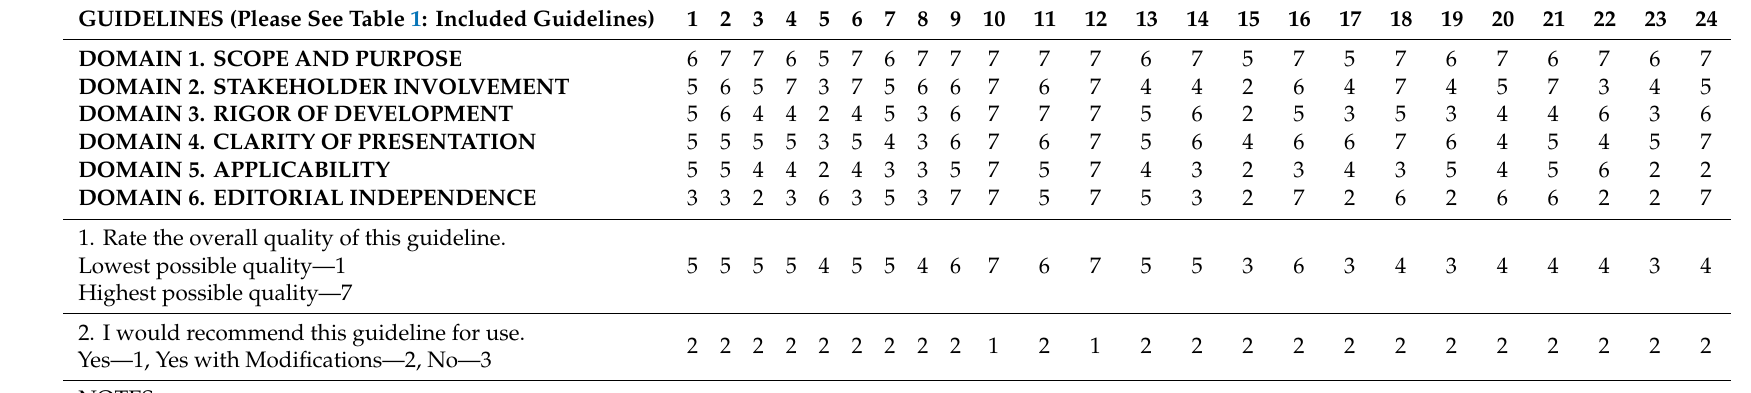
Table 3. Short version of the Agree II instrument (Strongly Disagree—1, Strongly Agree—7). GUIDELINES (Please See Table 1: Included Guidelines) DOMAIN 2. STAKEHOLDER INVOLVEMENT DOMAIN 4. CLARITY OF